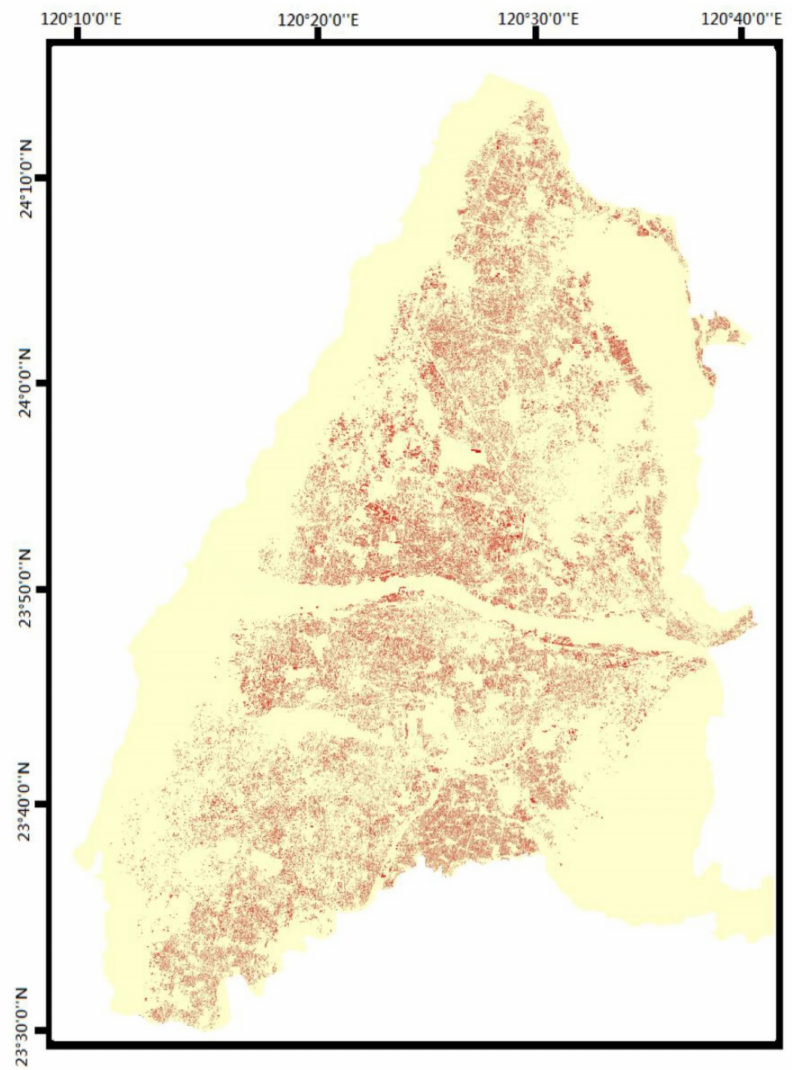
Figure 2. Rice ground data mapping from Agriculture and Food Agency (AFA) and Taiwan Agricul- ture Research Institute (TARI). Yellow indicates the study area, and red indicates the distribution of rice